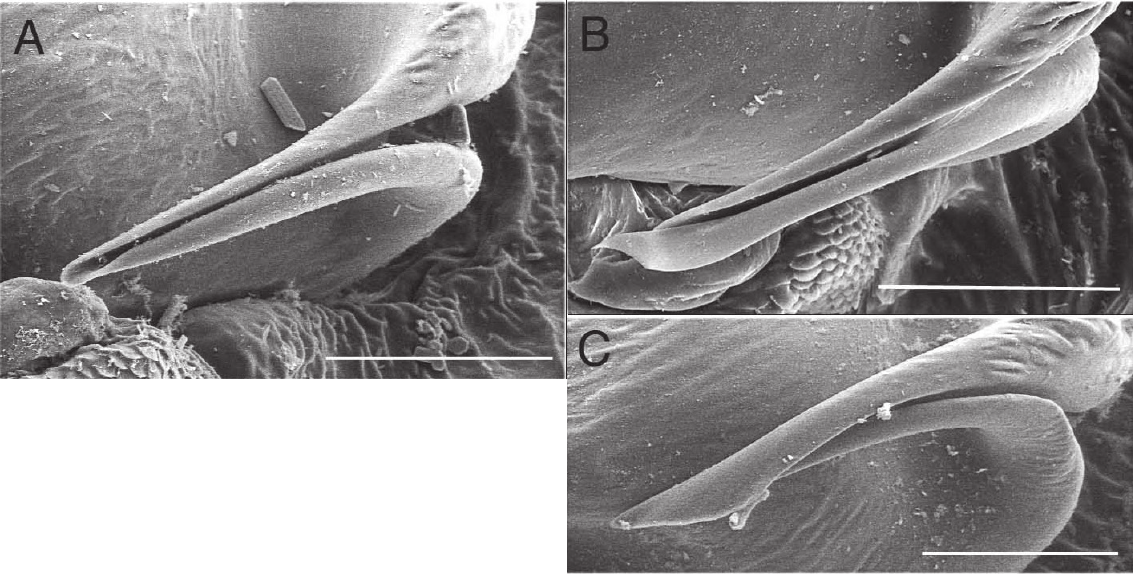
Fig. 6. Electron microscopic photographs of terminal apophysis of ♂ left palp. A . Eustala occidentalis sp. nov. B . Eustala meridionalis sp. nov. C . Eustala orientalis sp. nov. Scale lines = 0.1